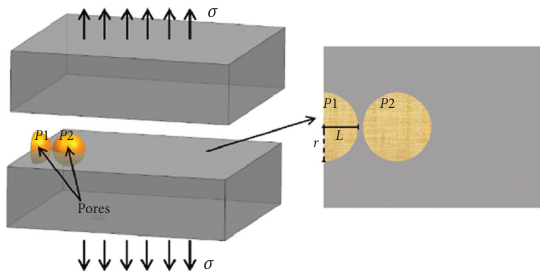
Figure 12: The schematic diagram of the theoretical model with pores on the surface of an infinite